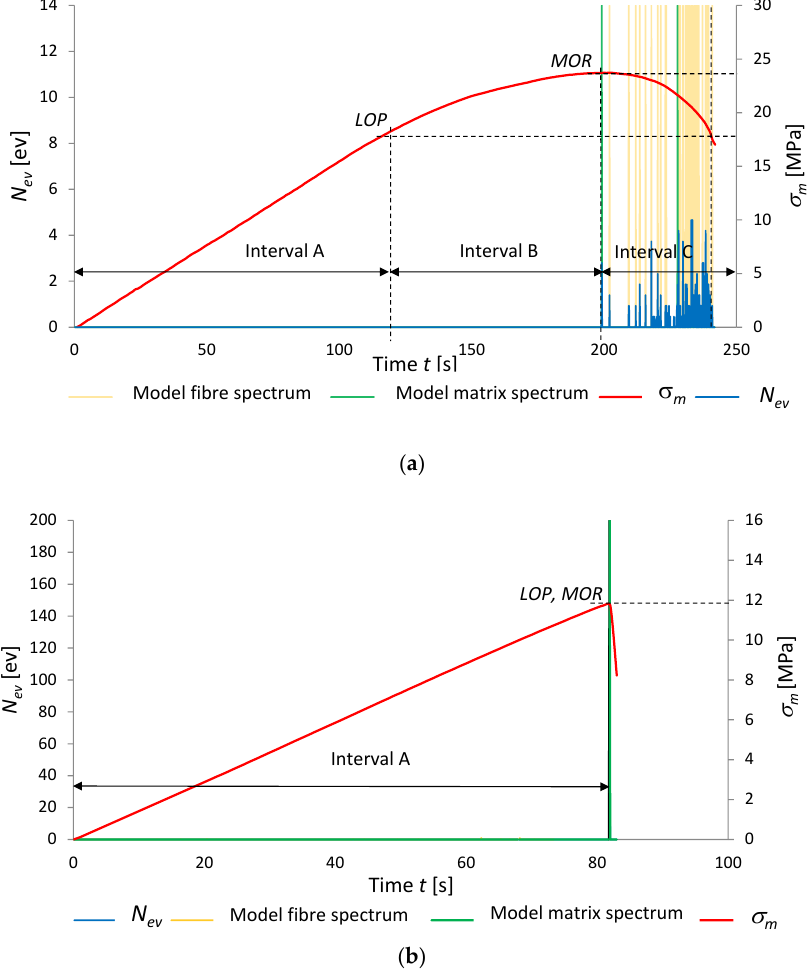
Figure 8. Events rate N ev and bending stress σ m versus time, under influence of fire, with marked identification of model spectral characteristics: ( a ) series A R , ( b ) series A T .